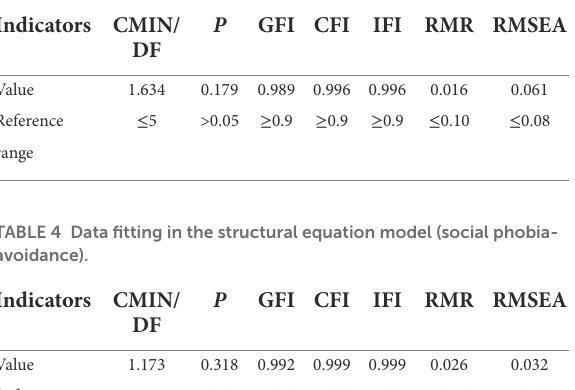
TABLE 3 Data fitting in the structural equation model (social phobia- fear).